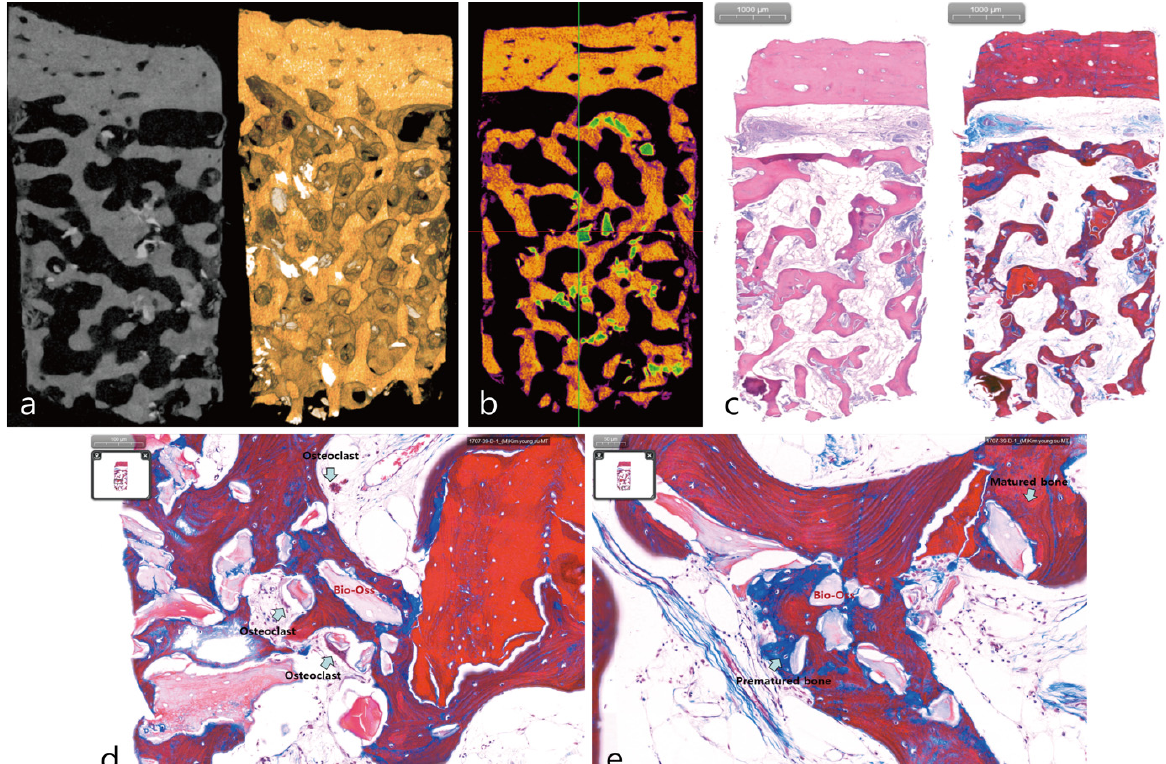
Figure 3. Micro-CT images and histologic finding of the bone core. ( a ) Micro-CT findings. Depro- teinized bovine bone mineral(DBBM)particles were interspersed between well-organized trabecular patterns. In the buccal side, a bony plate with good corticalization was observed. ( b ) The appearance of DBBM scattered in the bone core. ( c ) Histologic finding. There was a presence of highly vascularized soft tissue between the trabecular bones (left: H-E stain, right: MT stain). ( d ) DBBM particles and mature bone tissue (red color) were observed. Osteoclasts were also observed around DBBM particles (arrow). ( e ) A newly formed premature bone (blue color) and matured bone (red color) was observed around the DBBM particles (arrow).